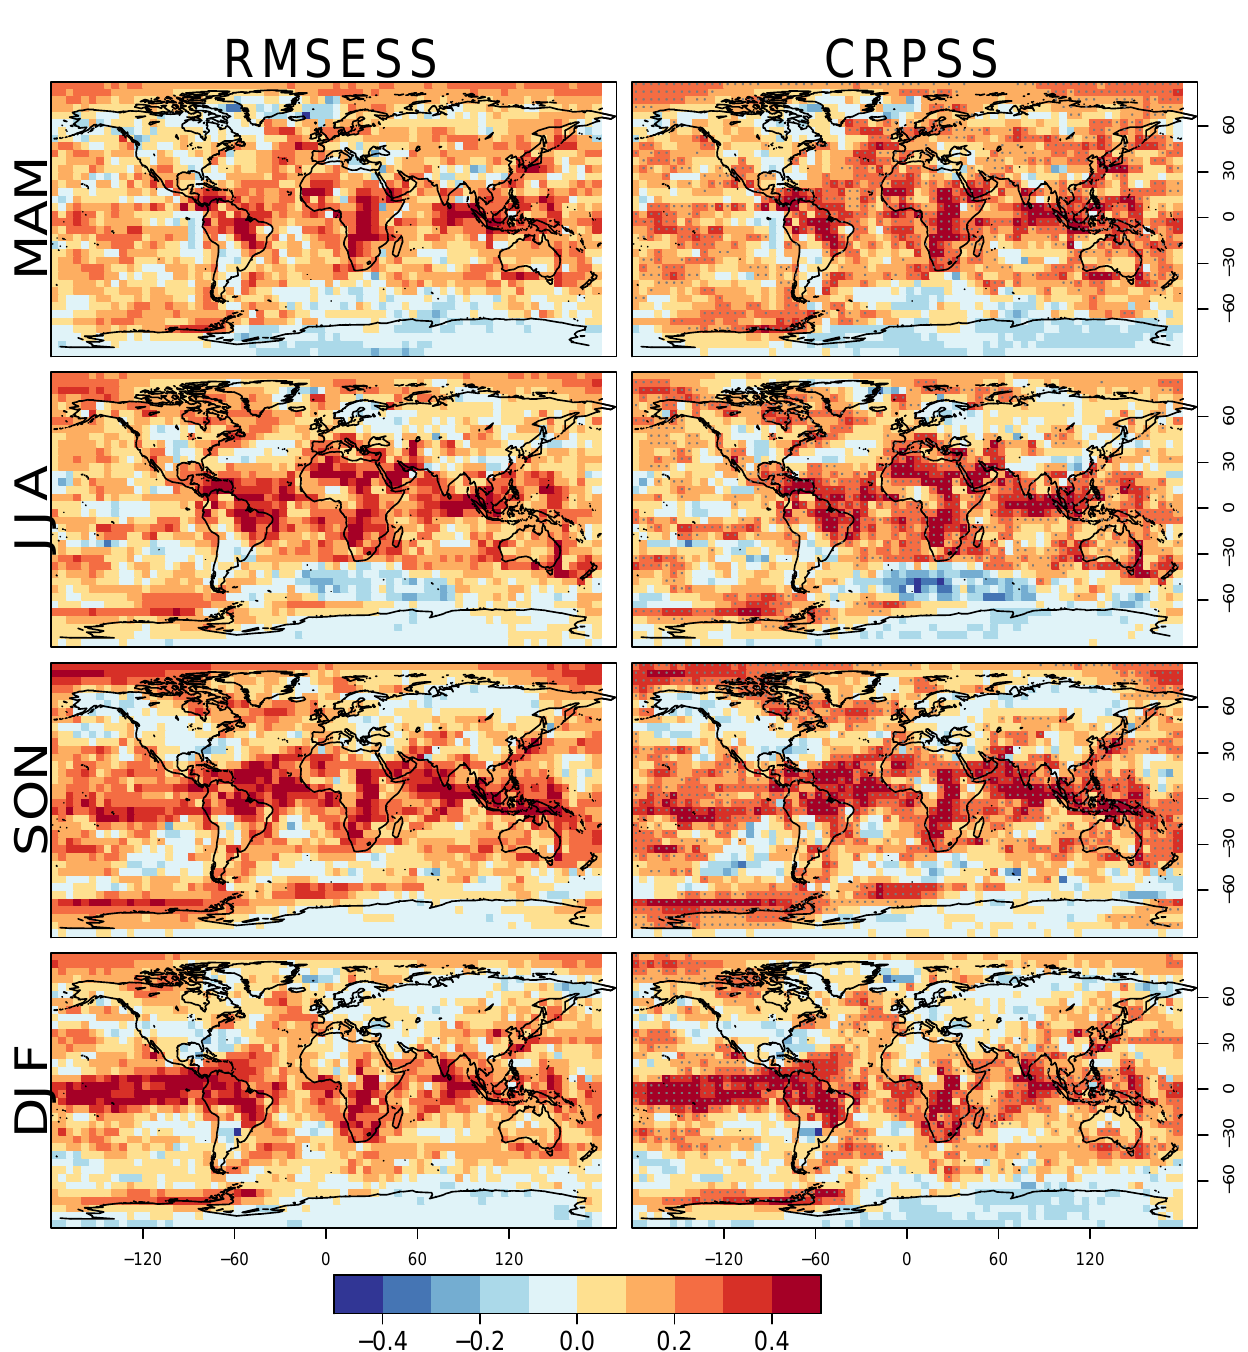
Figure 5. Root-mean-squared error skill score (RMSESS) and the continuous rank probability skill score (CRPSS) of the SAT hindcasts expressed as a skill score against a climatology ensemble forecast (1961–2013). For CRPSS, stippling is used to indicate significance at the 95% level following a one-sided t